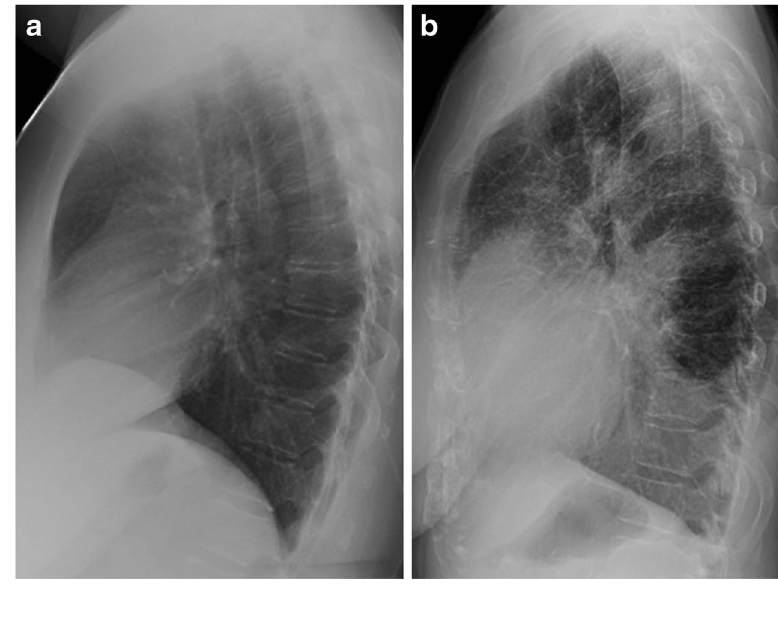
Fig. 2 Two examples of classic retrosternal clear space pathology: a lateral chest radiograph (a) and axial CT (b) showing an anterior mediastinal mass, and a lateral chest radiograph (c) and sagittal CT (d) showing an enlarged right ventricle and main pulmonary artery in a patient with pulmonary hypertension